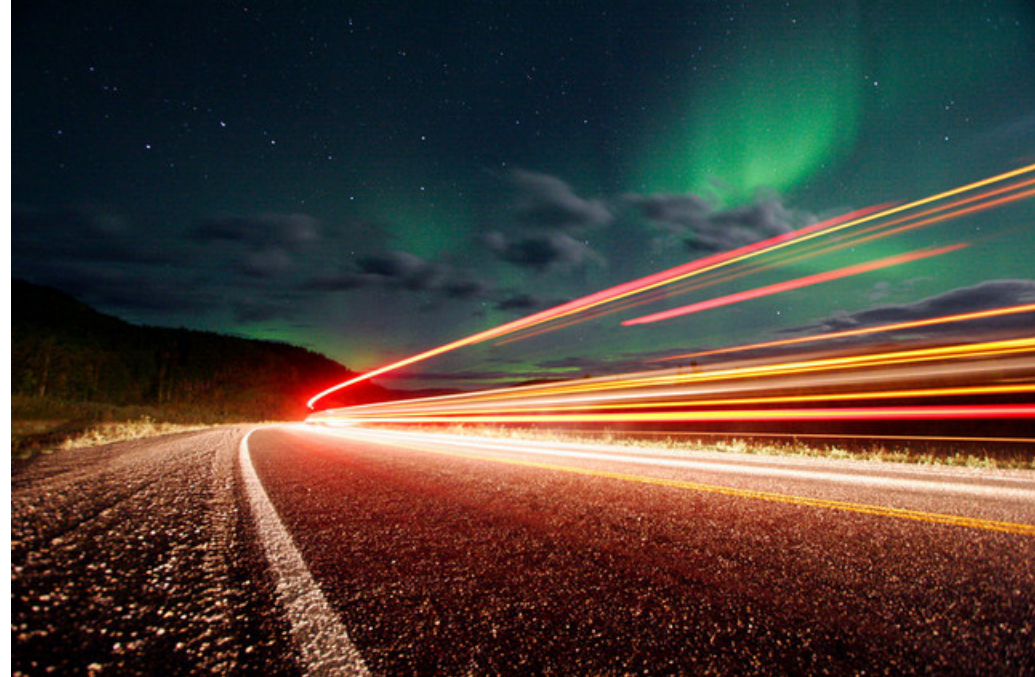
Figure 2. Braz’s inspiration image. Slow-exposure photography of highway perspectives. Source: K. Braz private